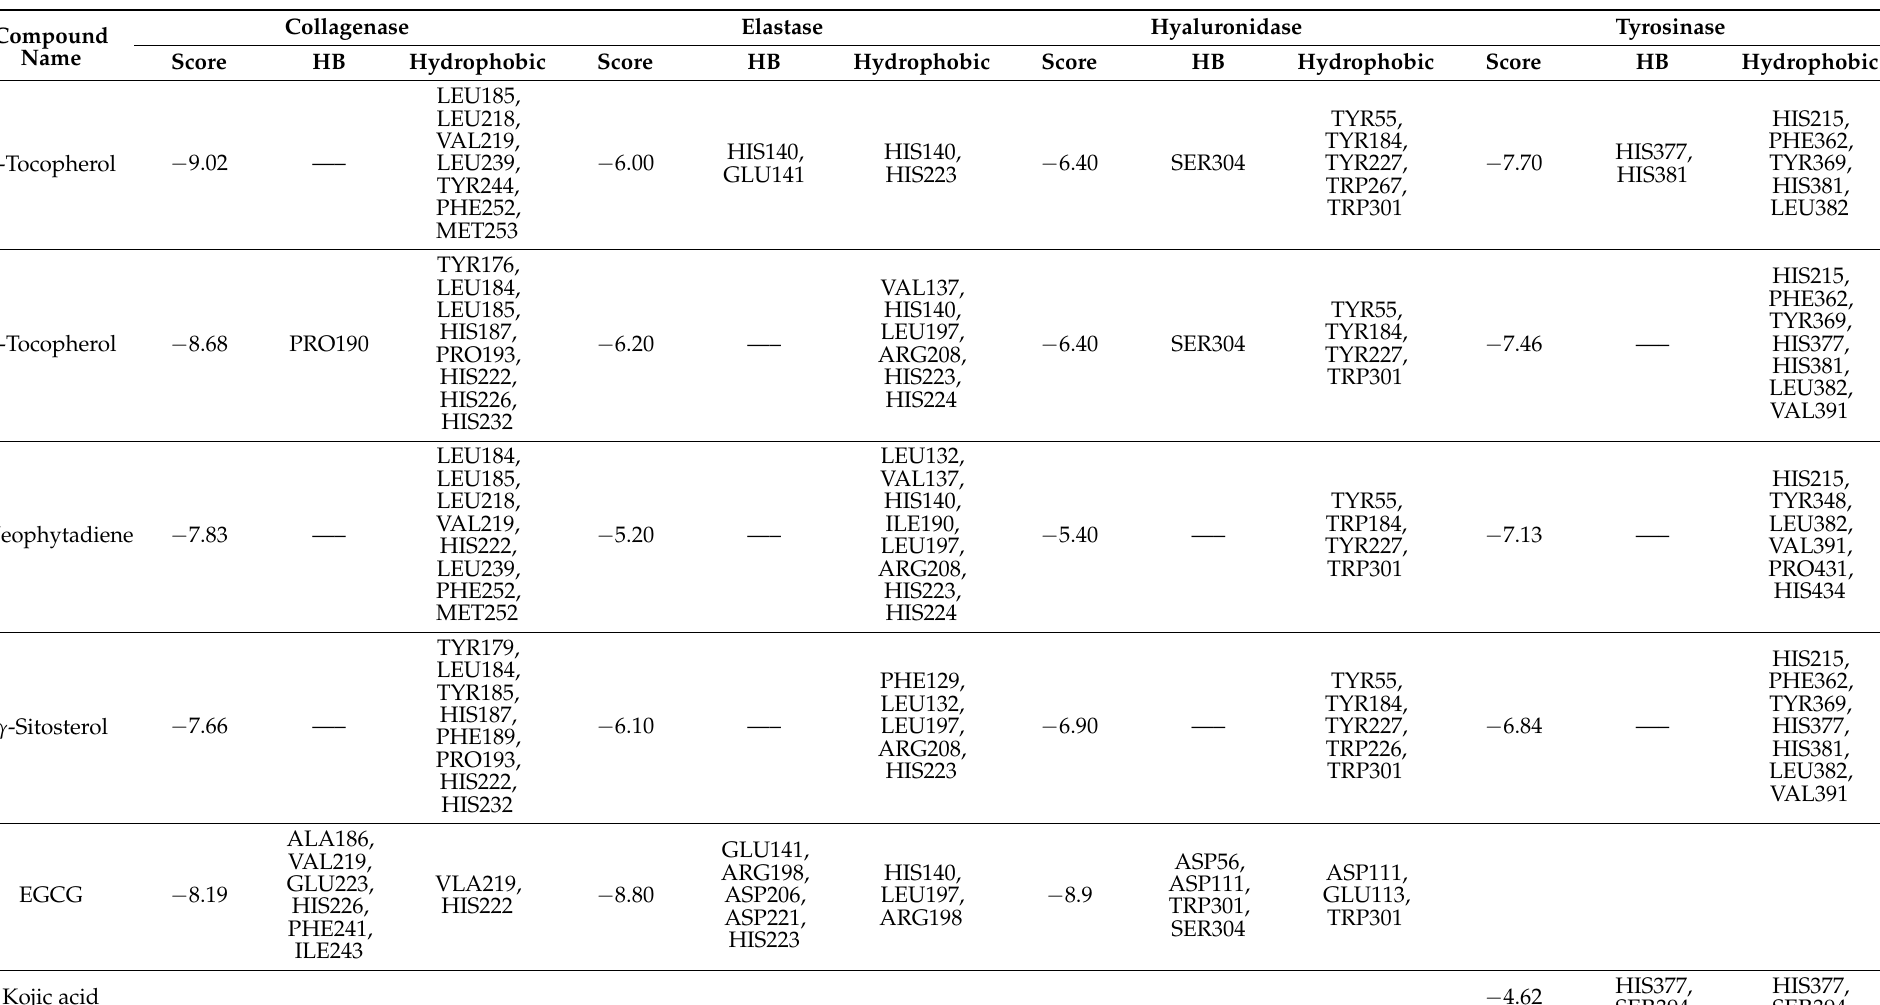
Table 2. Docking results regarding the main four isolated compounds and collagenase (456c), elastase (6qeo), hyaluronidase (1fcv), and tyrosinase